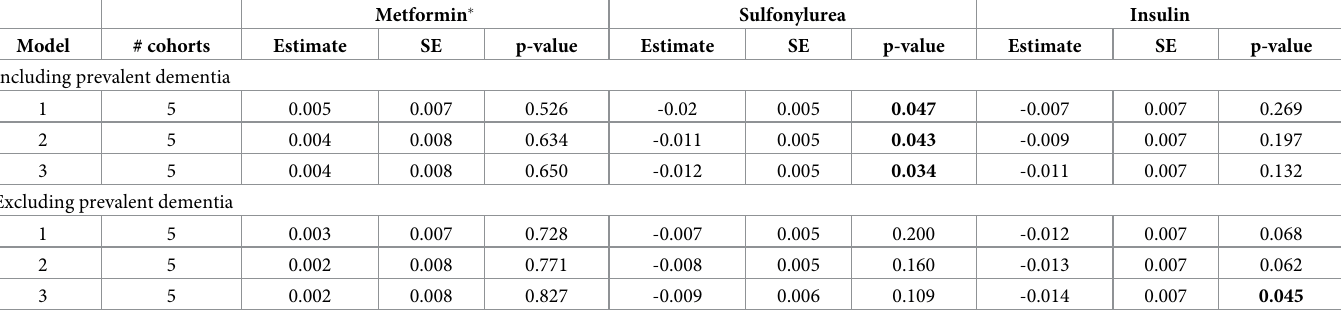
Table 4. Associations of diabetes drug classes (single or in combination) with change in global cognition among individuals with diabetes- Fixed effects meta- analysis.